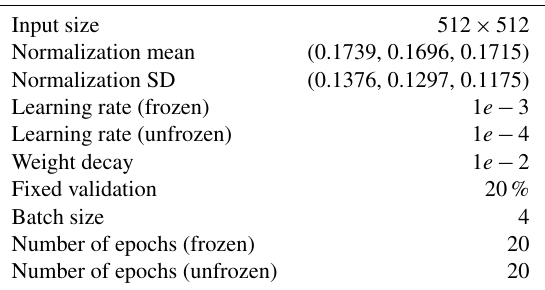
Figure 2. Diagram of exemplary inner deconvolution block. Input1 refers to the output from the preceding layer, whereas Input2 indi- cates a skip connection from the corresponding layer in the encoder part. After merging, convolutions and non-linear activations (ReLU) are applied to produce the upsampled output of this block. Table 1. Hyperparameters for training the segmentation